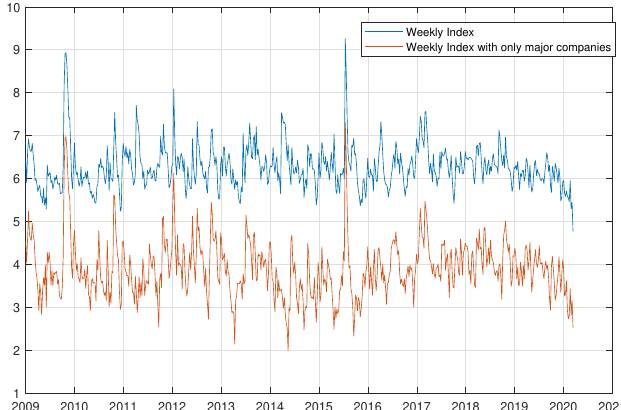
Figure 16. Comparison between the movie index constructed by considering all of the movies produced and distributed in the U.S. versus the index constructed by taking into account only those movies produced or distributed by major public companies.